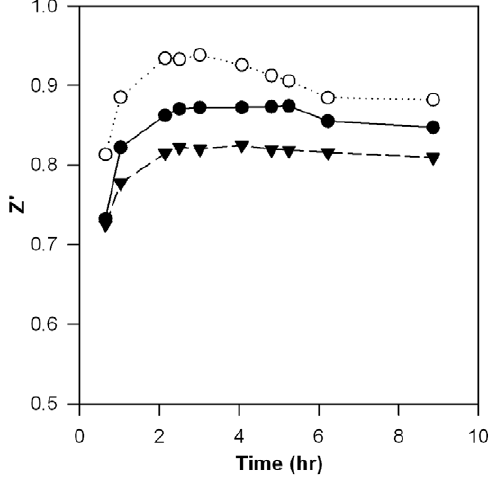
N Figure 2. Time course of measured Z ’ . Z’ was measured over time ), polypropylene ( . ), and commercially available low- in polystyrene ( binding ( # ) 384 well-plates. All wells contained 7.5 nM PA E733C*AF488 and 13 nM CMG2 R40C*AF546 in HBST plus either 5 mM NaCl (negative control; 168 wells) or 5 mM EDTA (positive control; inhibitor; 168 wells).